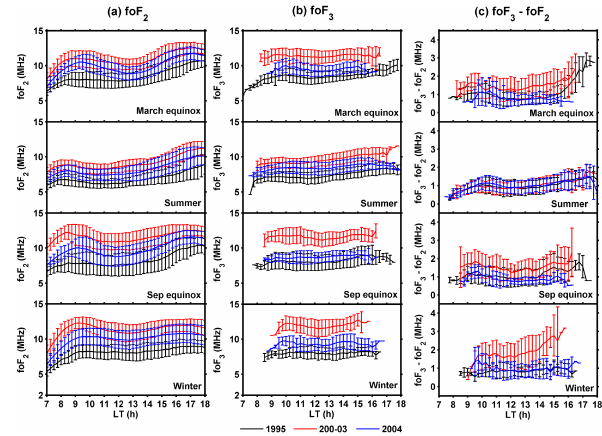
Figure 1. Local time variations of (a) f o F 2 and (b) f o F 3 as a func- tion of day number observed in 1995, 1998, 2002–2003, and 2004 (from top to bottom panels). These observations correspond to dif- ferent solar activity conditions (note the annual mean solar flux at 10.7cm ( F 10 . 7cm ) given in parentheses).